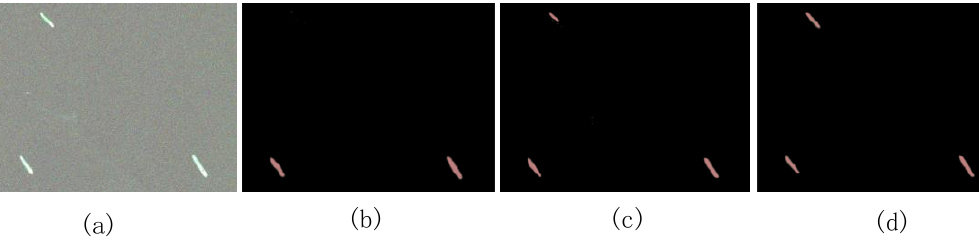
Figure 5. Semantic segmentation of ships under a calm sea surface with Gaussian noise.( a ) Original ( b )CRF-RNN ( c ) DeepLab ( d ) Proposed model.